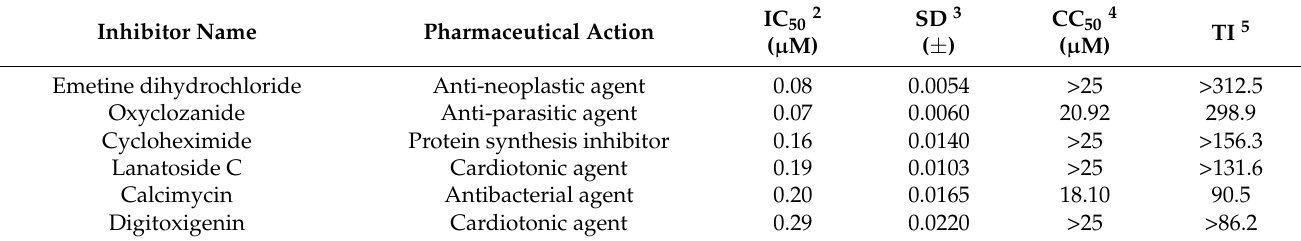
Table 4. Hit profiling and anti-MERS-CoV efficacies of selected bioactives in Vero cells 1